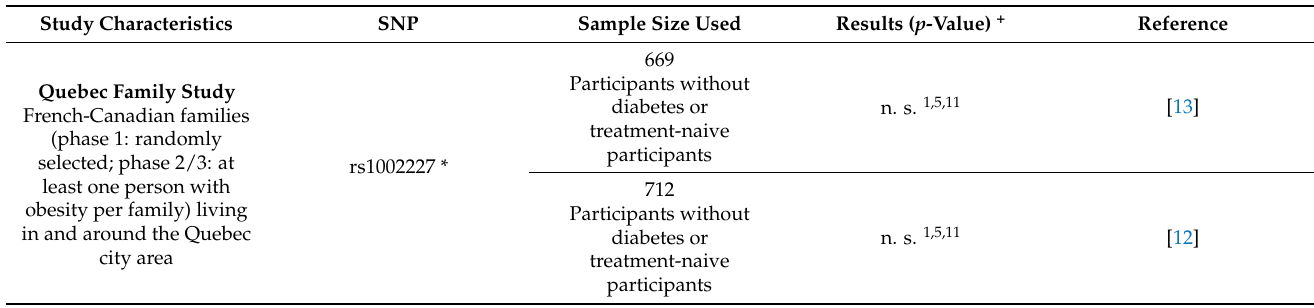
Table 3. Associations between potassium inwardly rectifying channel subfamily J member 11 ( KCNJ11 ) SNPs and gAUC after an OGTT in